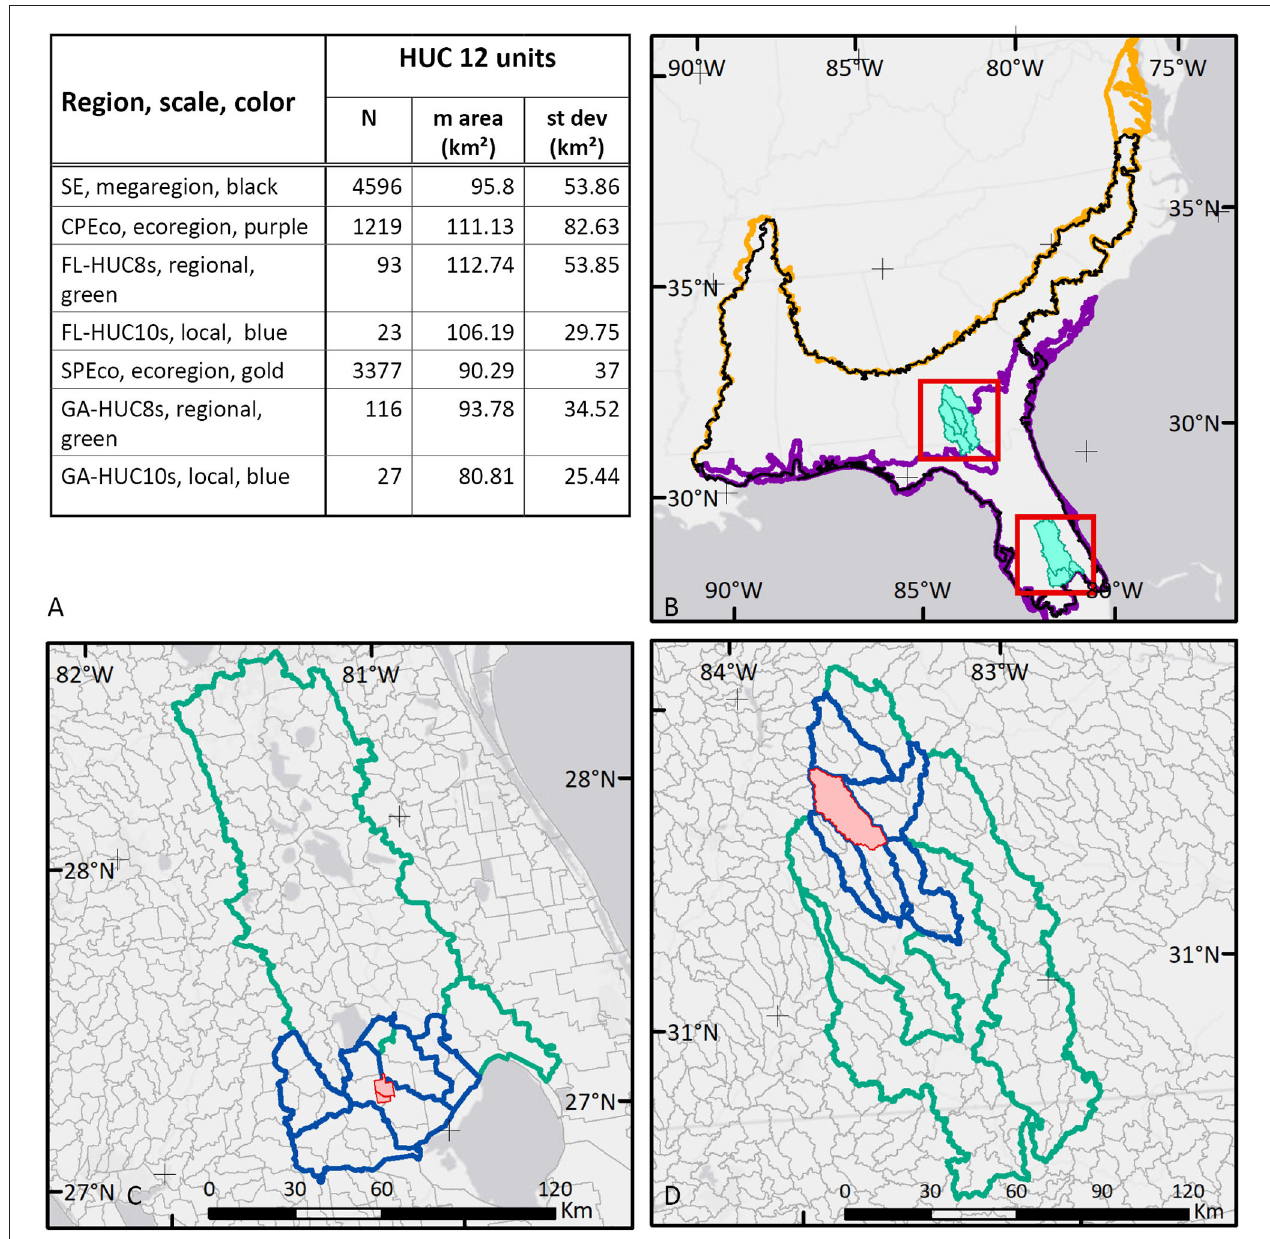
FIGURE 2 | The southeastern US showing ecoregion and study area boundaries with HUC-12 unit summary. (A) Table describing study area names, scale, and map color, and showing count, mean and standard deviation of HUC-12 areas within the study area boundaries. (B) Southeast mega-region (SE, black outline), with Southeastern Plains Ecoregion (SPEco, gold outline), and Southern Coastal Plain ecoregion (CPEco, purple outline). (C) Florida study areas—FL-HUC8s (green outline), and FL-HUC10s (blue outline). (D) Georgia study areas—GA-HUC8s (green outline), and GA-HUC10s (blue